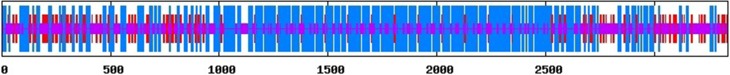
Secondary structure of polyketide synthase 3 in A. limacinum.Note: The longest blue stub show Alpha helix, the longer red stub show Extended strand and the shortest orange show Random coil.